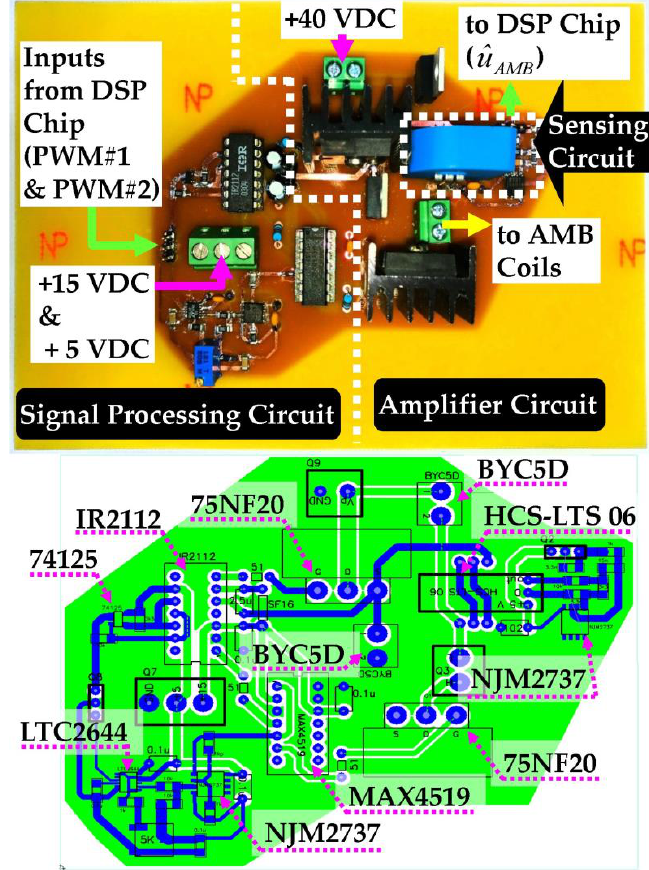
Figure 12. Photograph and layout of dual cooperative drive circuit (DC 2 ).